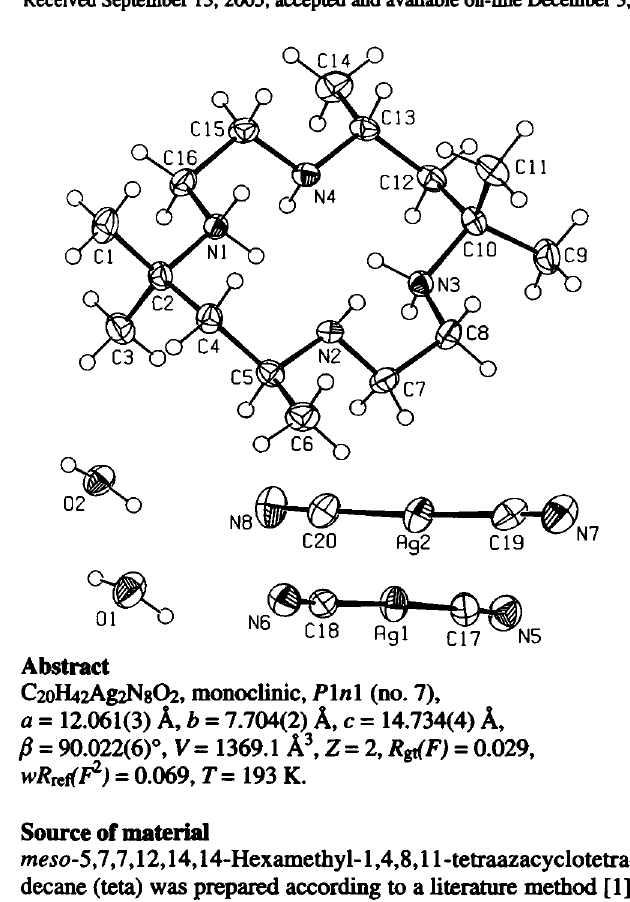
Table 2. Atomic coordinates and displacement parameters (in A 2